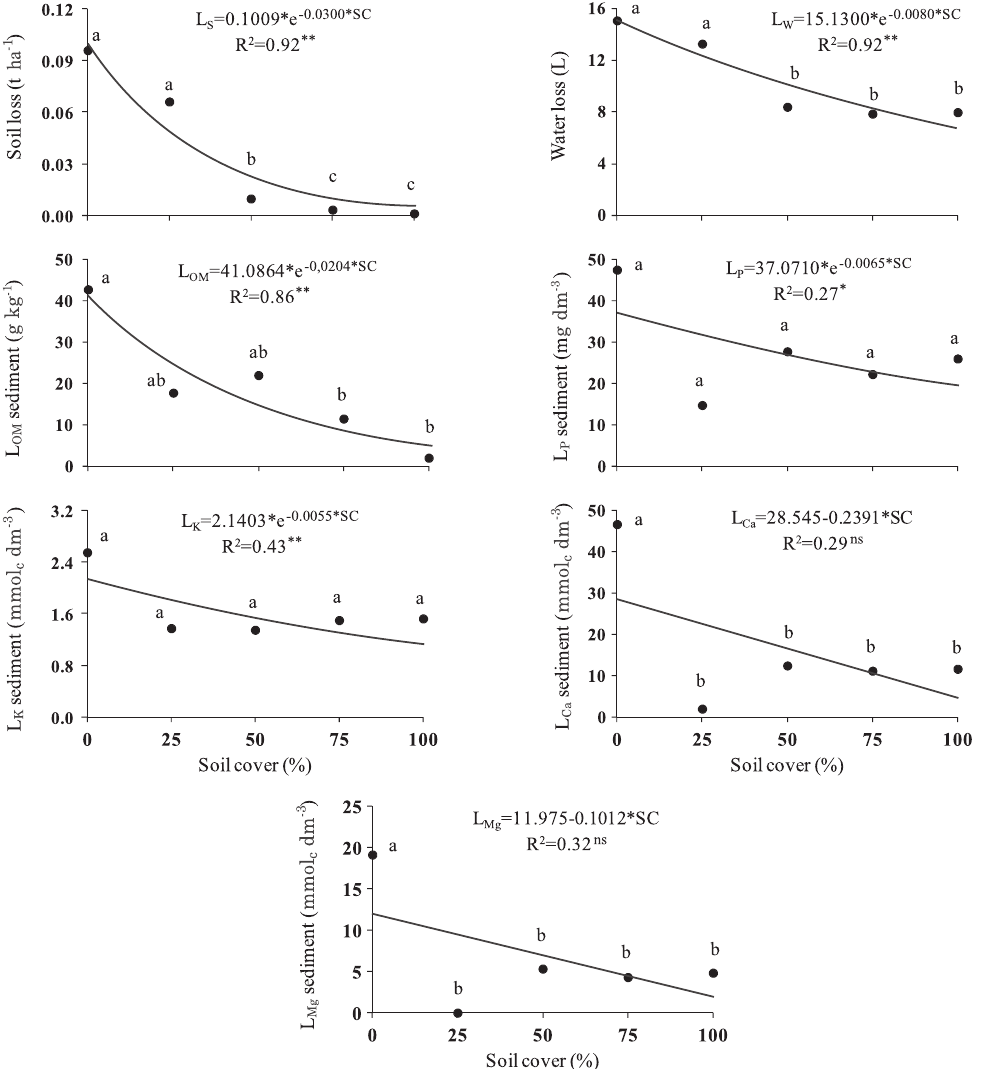
figure 1. Soil losses (l S ), water (l W ), organic matter (l om ) and nutrients (l P , l K , l Ca and l mg ) by interrill erosion from plots with different amounts of cane trash on the soil surface (0, 25, 50, 75, and 100 %) under the rain event studied. averages of the same treatment followed by the same letter differed by the duncan test (p <